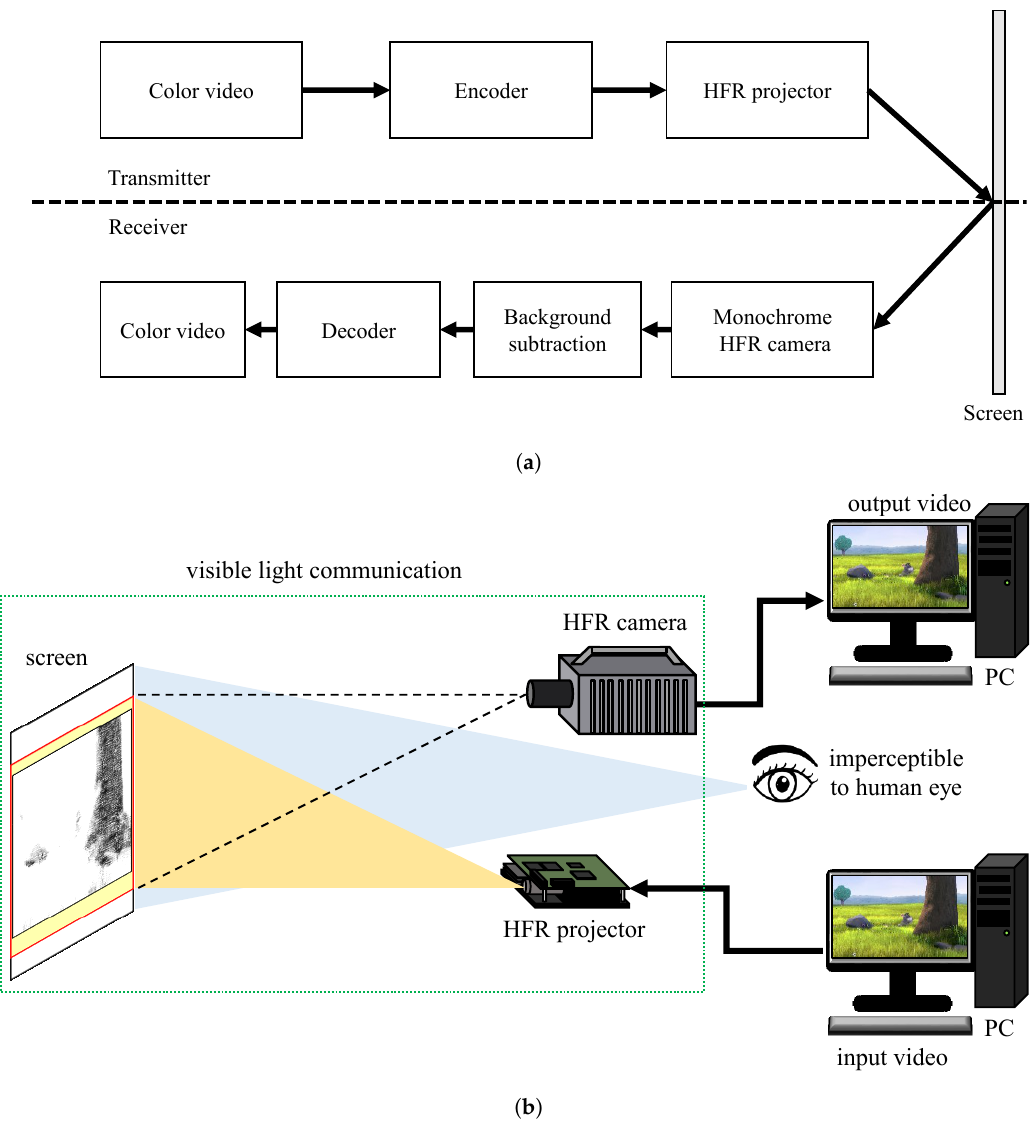
Figure 1. ( a ) block diagram and ( b ) configuration of the proposed VLC